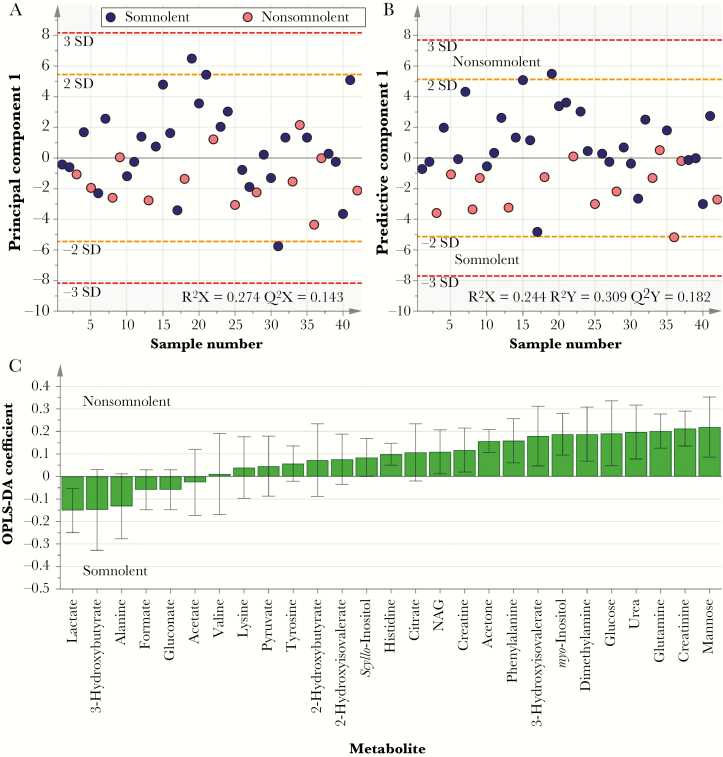
Metabolic changes in cerebrospinal fluid (CSF) associated with somnolence. A, Principle component analysis score plot, comparing metabolic phenotypes for somnolent patients (n = 14) to those for nonsomnolent patients (n = 28). B and C, Cross-validated orthogonal partial least squares discriminatory analyses (OPLS-DA) score plot (B) and corresponding loadings plot (C). Partial separation between the 2 groups along the first component is apparent across both models. NAG, N-acetyl glycoprotein.